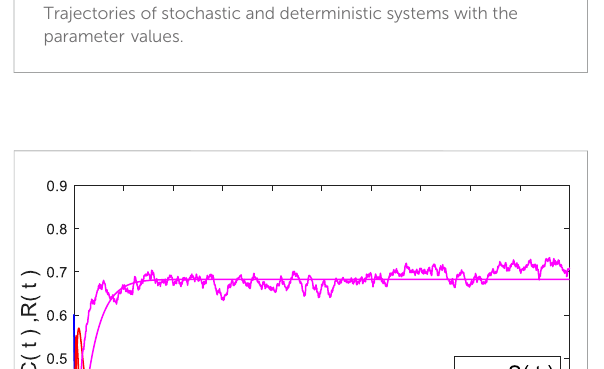
FIGURE 2 Trajectories of stochastic and deterministic systems with the parameter values.